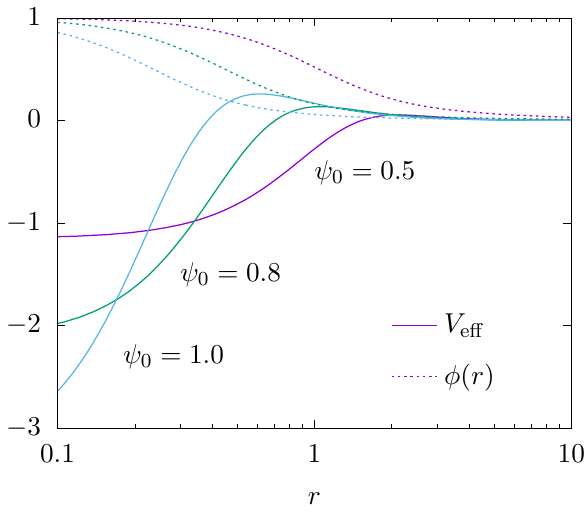
Figure 3 . We show the effective potential V eff (solid) of (3.9) for three different values of ψ 0 for γ < 0, α = 0. We also give the corresponding bound state solution φ ( r ) for these same values of ψ 0 (dashed). For values of α and γ < 0, respectively, see table